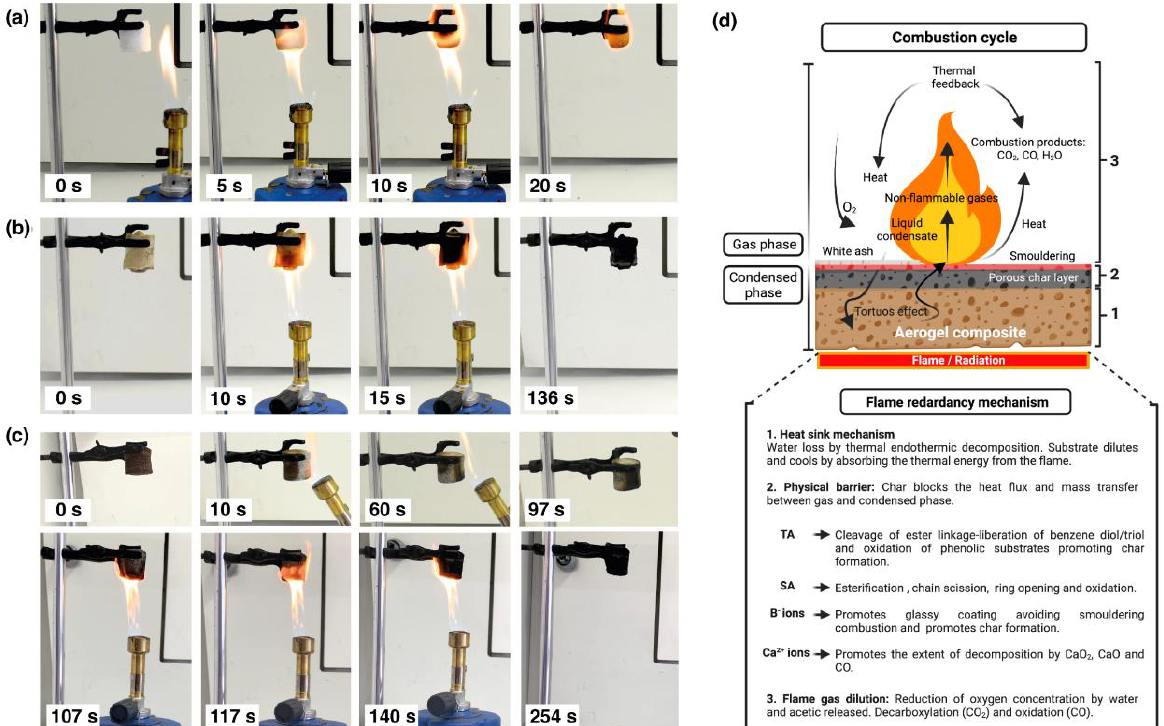
Figure 6. Flame behavior of ( a ) P5, ( b ) P5T3A3 uncrosslinked, and ( c ) crosslinked aerogels under Bunsen burner. ( d ) Diagrammatic scheme of combustion cycle and the flame retardant mechanism (Created with Biorender.com Agrmt. No.HF242VFEC0).